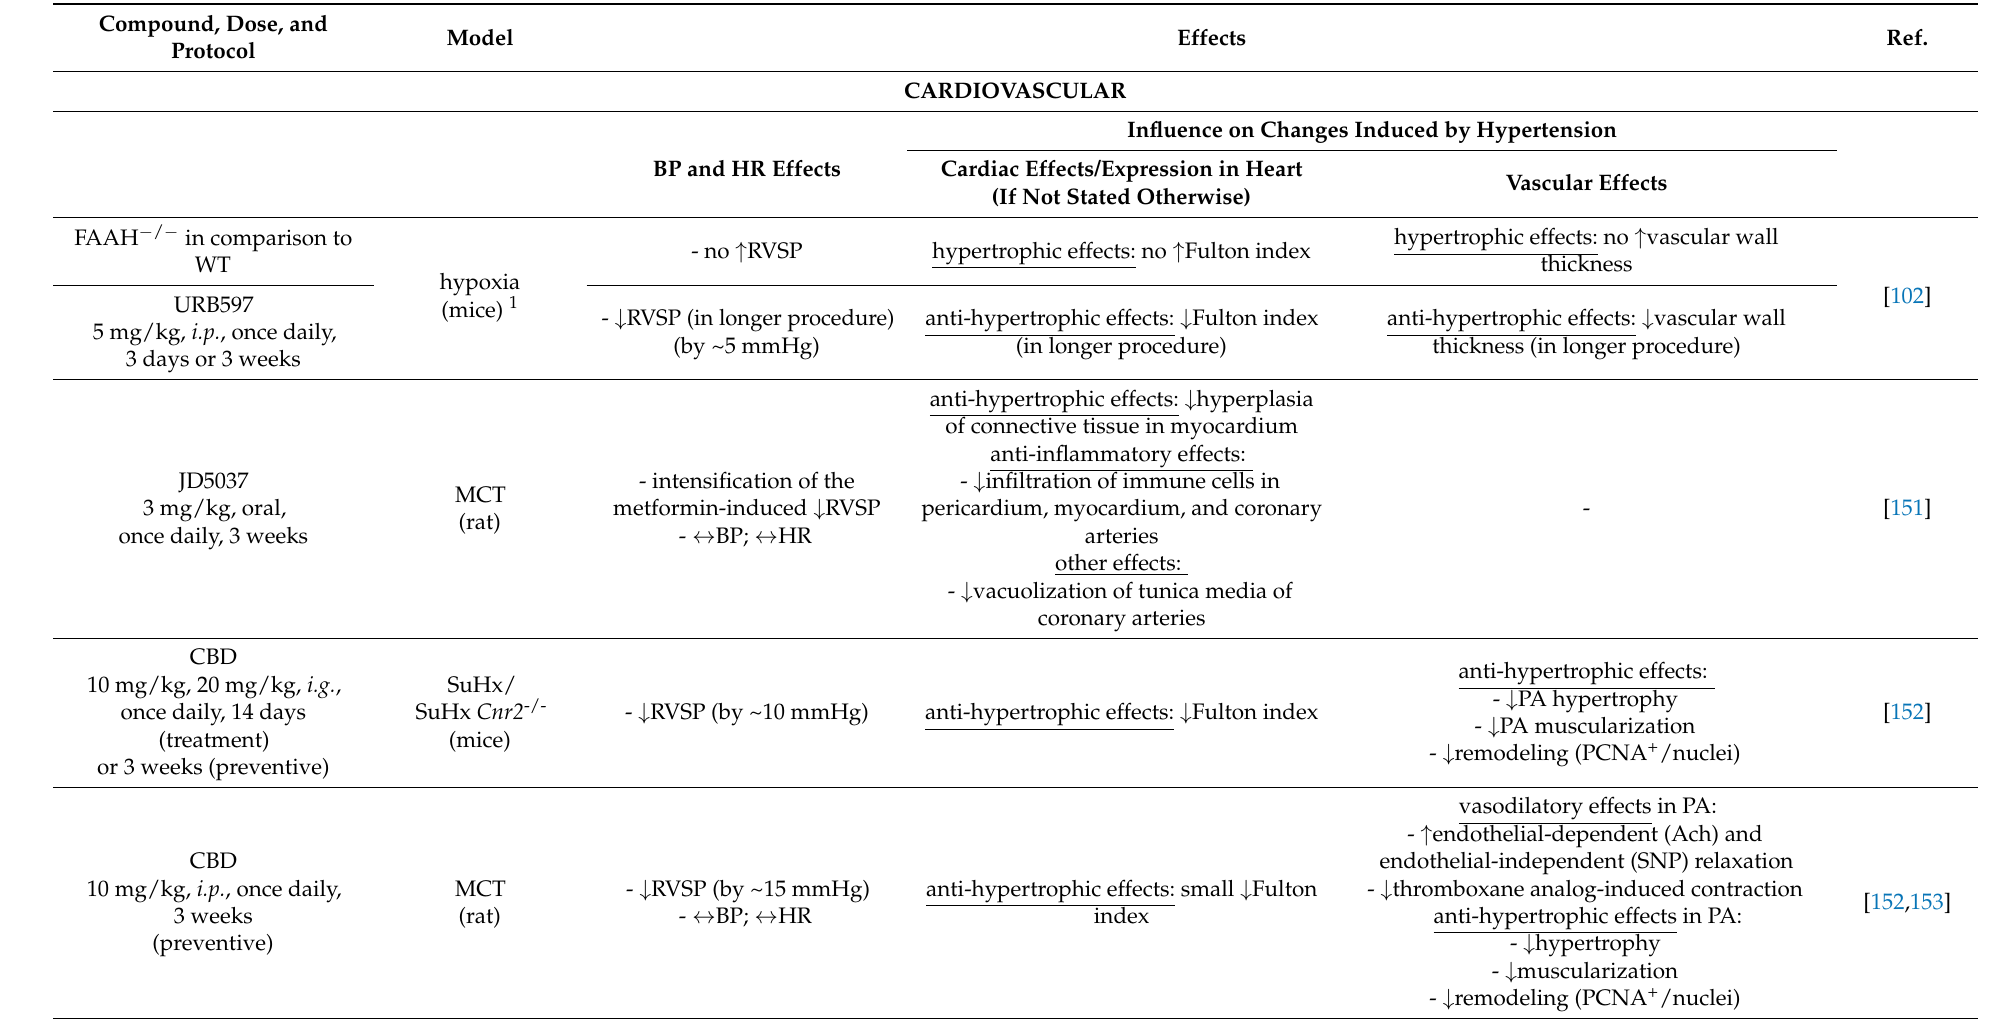
Table 5. Effects of chronic administration of cannabinoids on various tissues of male animals (unless noted otherwise) in different models of pulmonary hypertension. Compound, Dose,